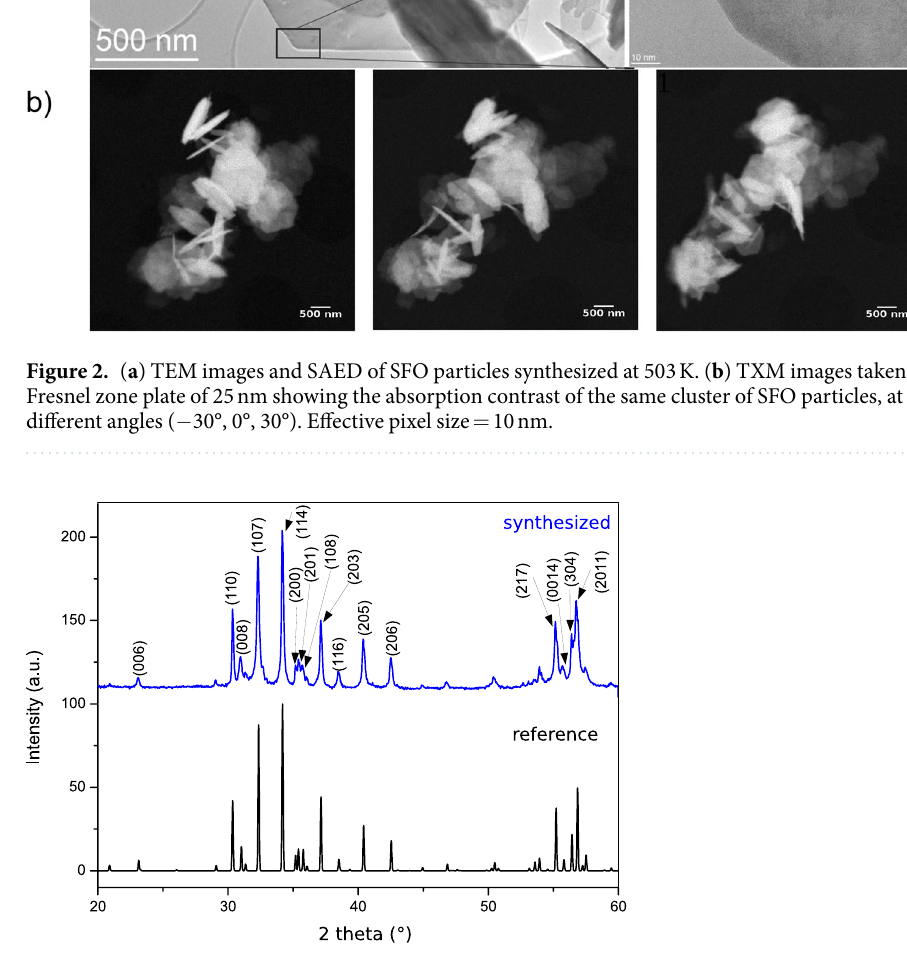
Figure 3. XRD diffraction patterns from the SFO particles synthesized at 503 K (top spectrum), together with the reference pattern (bottom